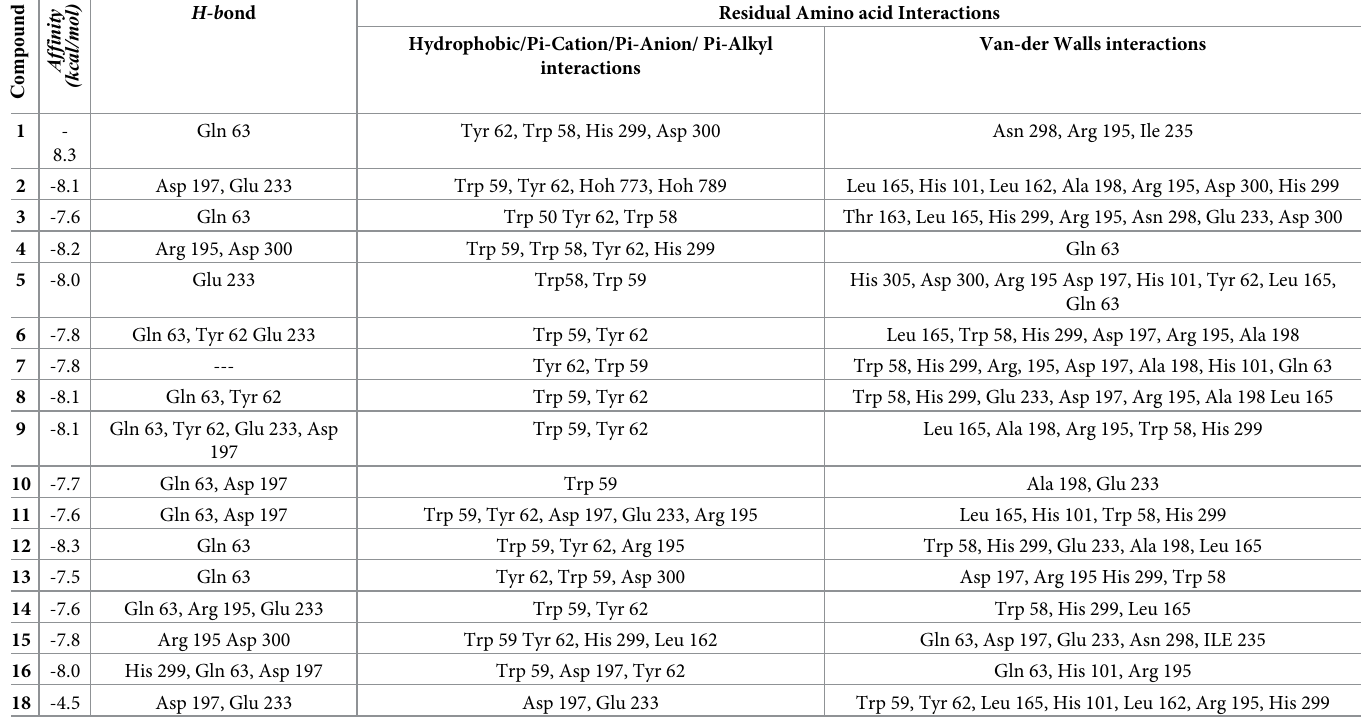
Table 8. Molecular docking value of flavonoids against Human α -amylase (PDB ID: